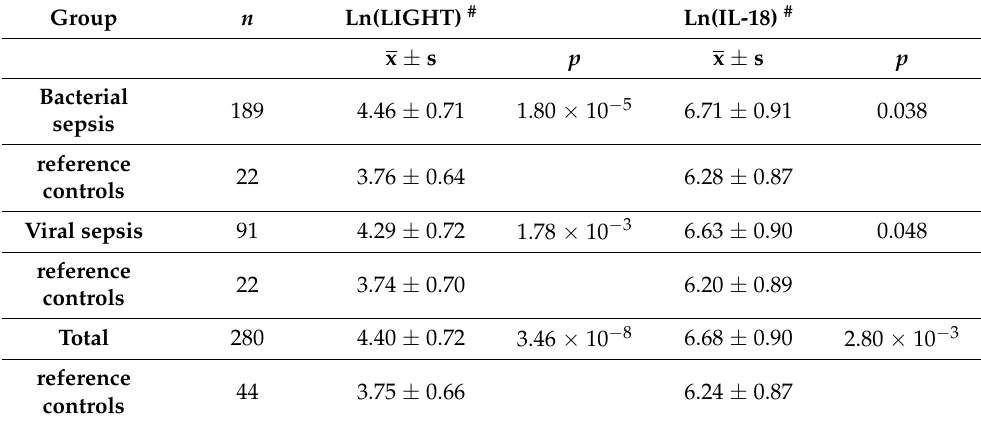
Table 2. Ln (LIGHT) and Ln (IL-18) levels in bacterial and viral sepsis.